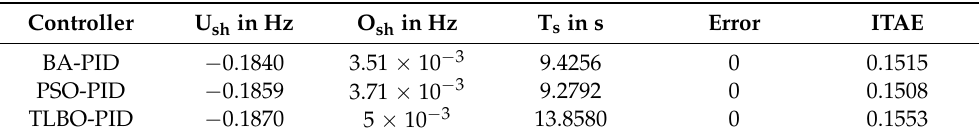
Table 8. Frequency response performances with PID tuned by different algorithms and designed by minimizing ITAE.